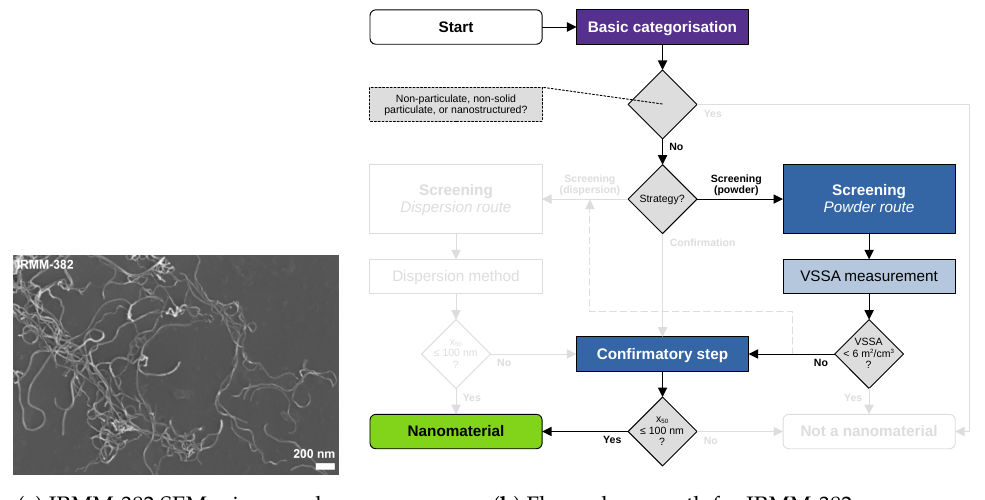
Figure 7. IRMM-382 (multi-walled carbon nanotubes): ( a ) representative SEM micrograph, and ( b ) the respective flow scheme path. The tier 1 BET method yielding a considerably large VSSA = 480 m 2 /cm 3 makes it viable to skip a switch to the dispersion route using other screening tier 1 methods and continue with a subsequent confirmatory step. The following tier 2 method TEM with an x 50 = 12 nm leads to a “nanomaterial”